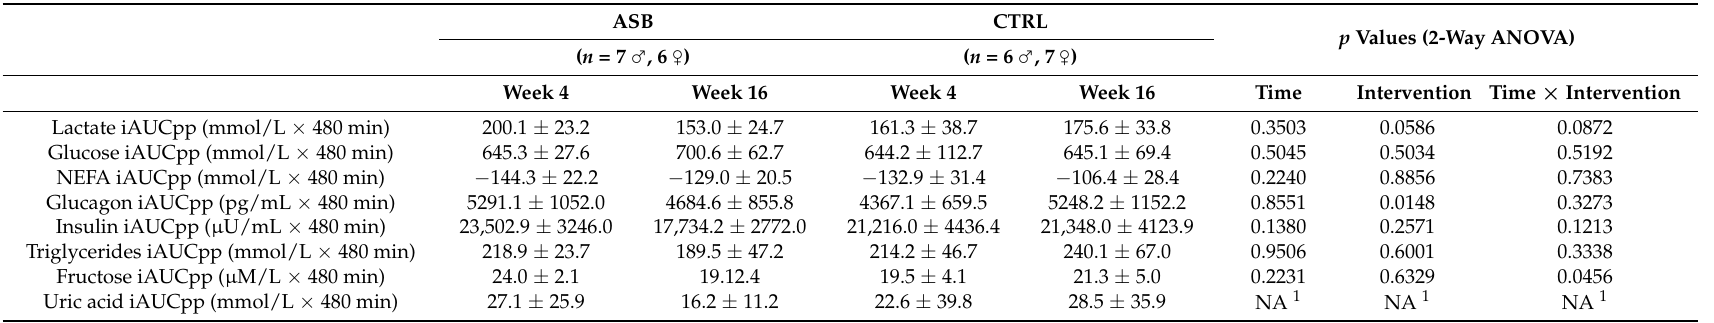
Table 2. Postprandial incremental area under the curve (iAUCpp) of metabolites and hormones concentrations in all participants. Values are expressed as mean ± 1